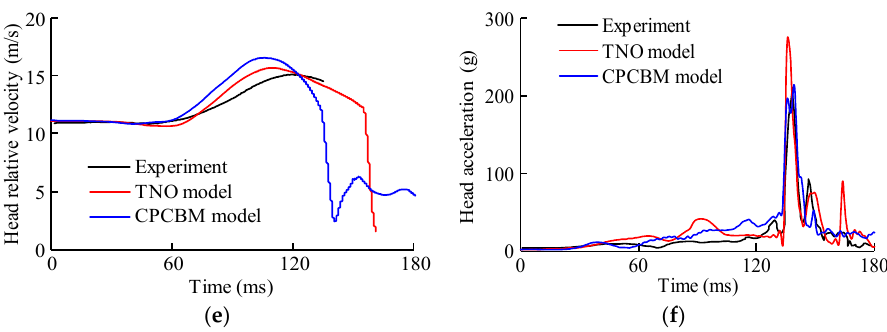
Figure 6. Comparisons of analyzed responses for test V2370 [17] between the TNO model, CPCBM and the experimental data: ( a ) the head center of gravity (COG) displacement in X direction, ( b ) the head COG displacement in Y direction, ( c ) the head COG displacement in Z direction, ( d ) the head COG trajectory in the YOZ plane, ( e ) The head COG resultant velocity relative to the impact buck, ( f ) the head COG resultant acceleration.